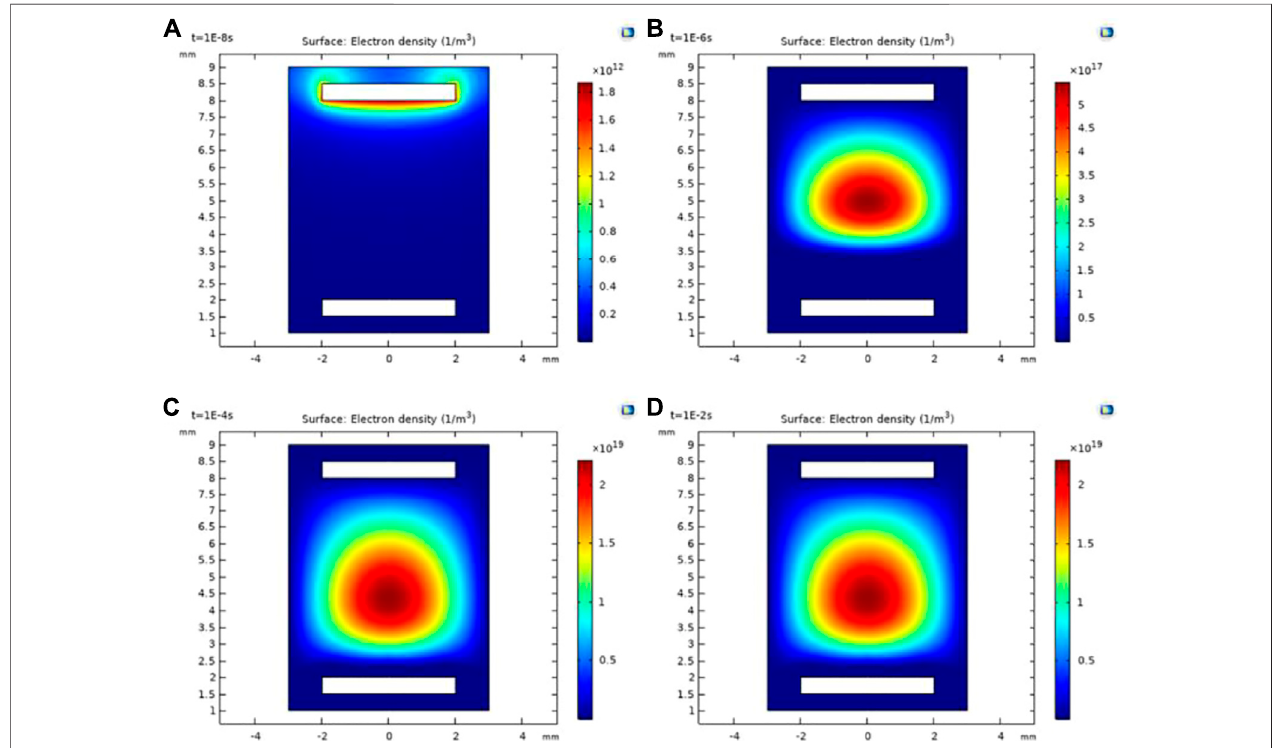
FIGURE 2 | Distributions of electron density at different times. (A) t (cid:2) 1 . 0 × 10 − 8 s; (B) t (cid:2) 1 . 0 × 10 − 6 s; (C) t (cid:2) 1 . 0 × 10 − 4 s; (D) t (cid:2) 1 . 0 × 10 − 2 s .